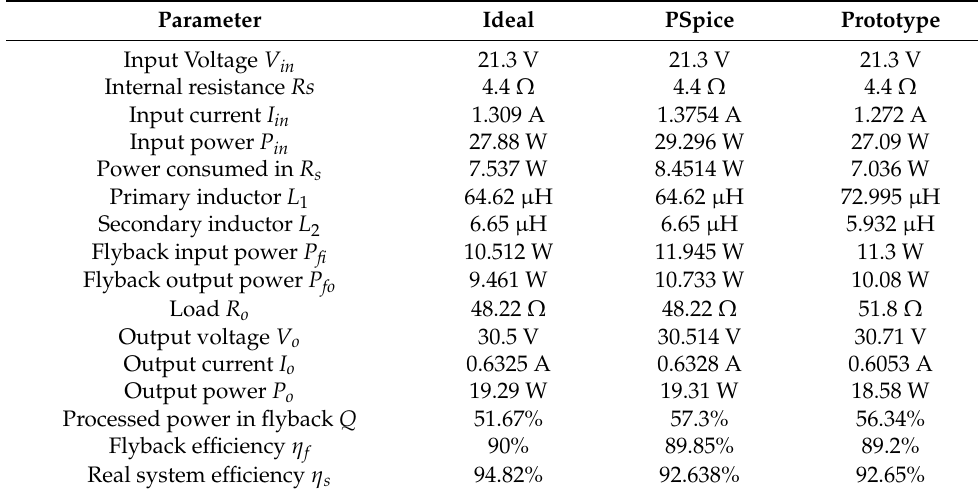
Table 4. Summary of results of the topology.